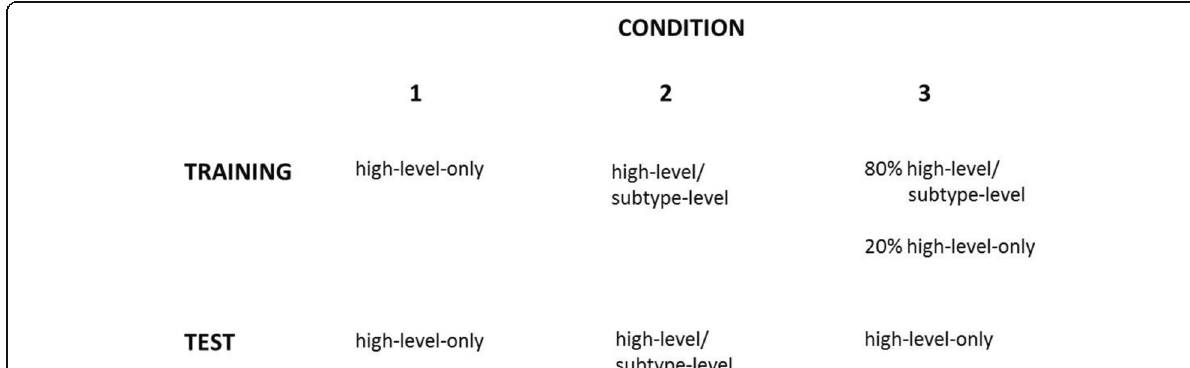
Fig. 5 Schematic summary of the training and testing procedures across conditions 1 – 3. In the high-level-only response mode, participants classified each item into either the igneous, metamorphic or sedimentary high-level categories. In the two-stage high-level/subtype-level mode, participants first made the high-level response, followed by a subtype-level response from among the subtypes that were members of the chosen high-level